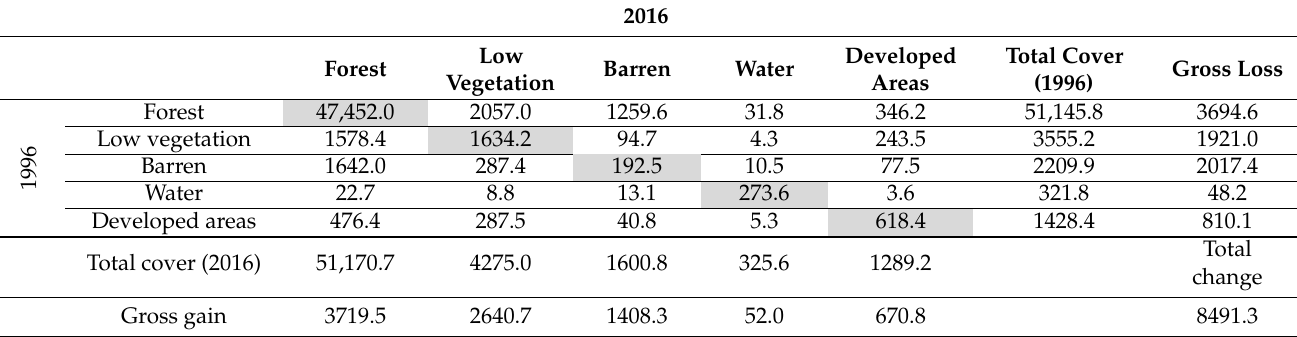
Table 9. The transition matrix of the Coal River head watershed from 1996 to 2016. Values are in